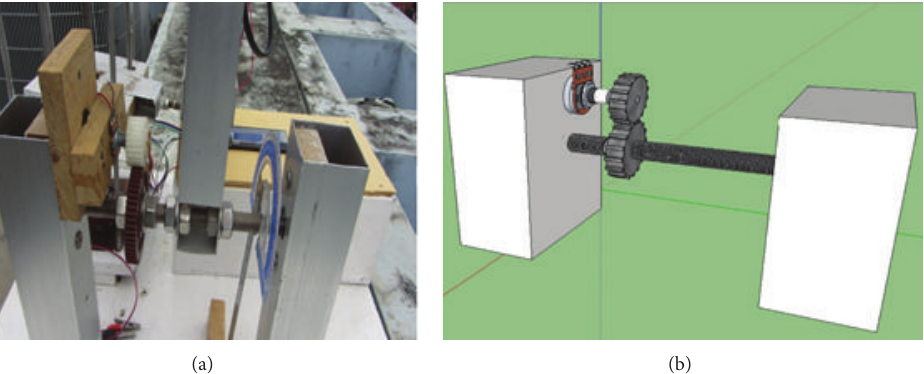
Figure 4: Design and implementation of panel carrier rotator: (a) implementation and placement of panel carrier rotator with the panel carrier and a wooden base; (b) hardware design of panel carrier rotator in computer aided drafting tool.